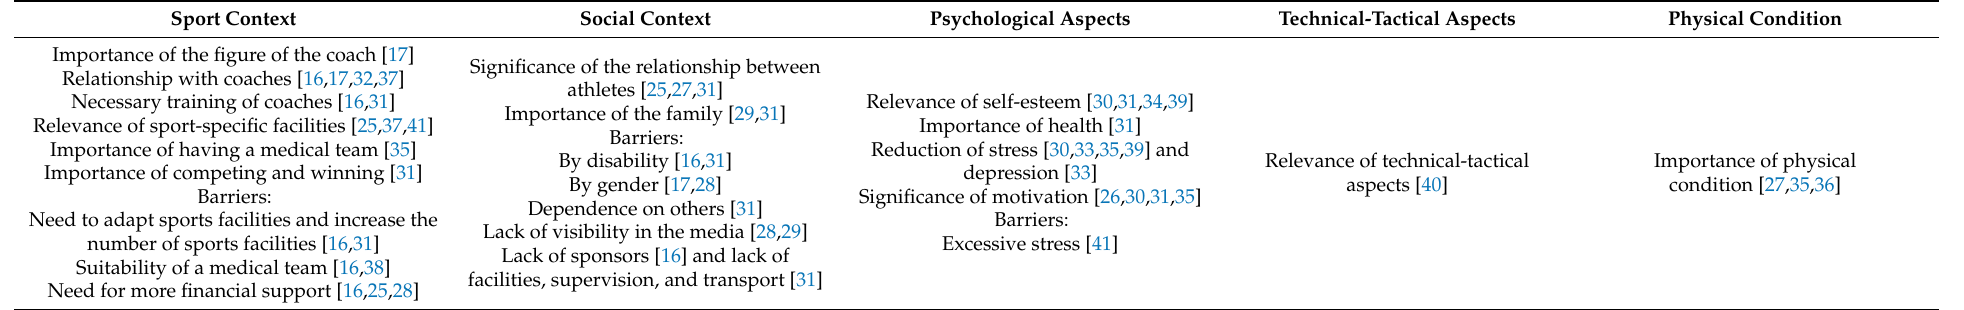
Table 5. Outstanding aspects in the training process of